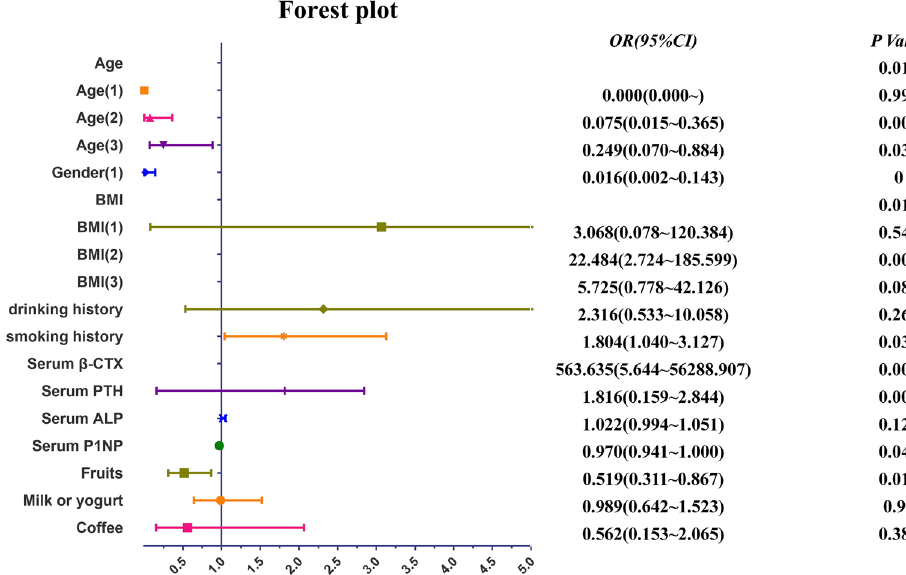
Figure 4. Forest plot of factors associated with OP in CG